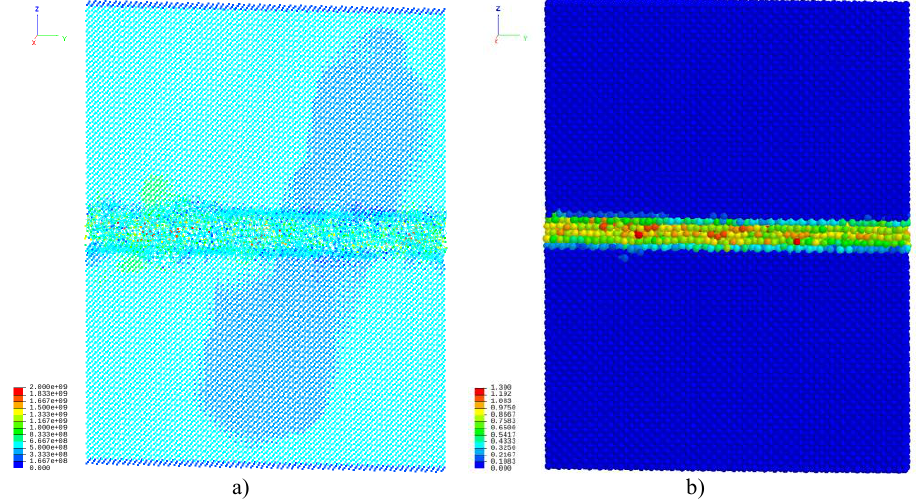
Fig. 3. Fields of equivalent stress (a, points are centres of automata) and strain (b, automata shown as spheres) in the cross-section of the steel specimen at the final stage of the